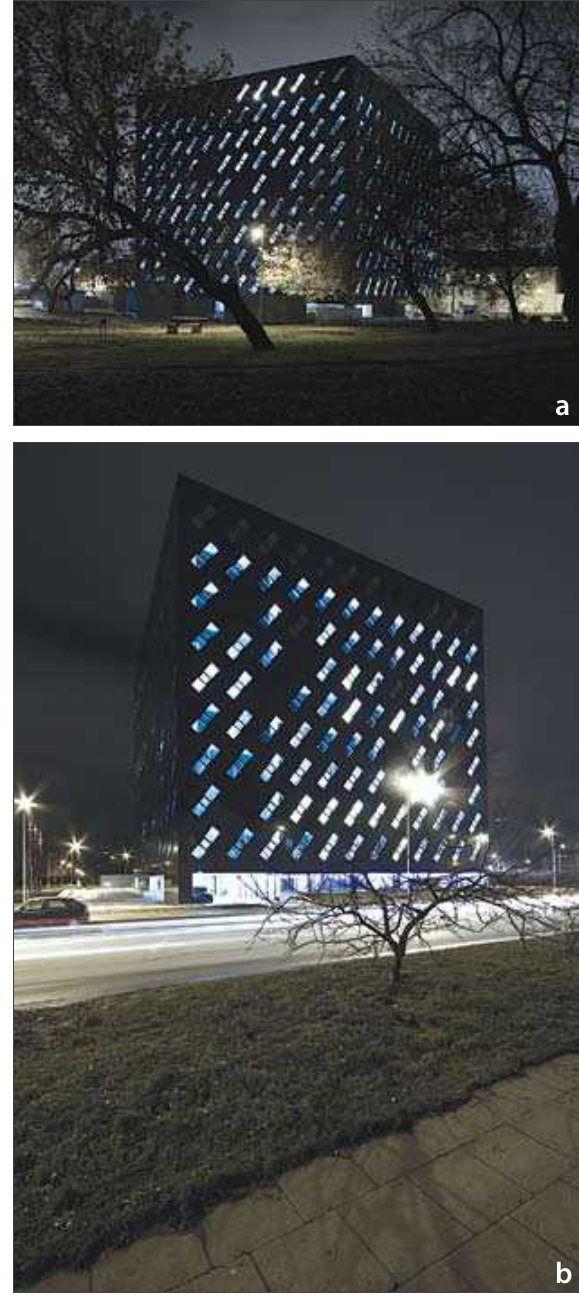
archit. k. Lupeikis, 2008 m. Fig. 18. Prosecutor's Office building at night (a, b), Vilnius. arch. k. Lupeikis,